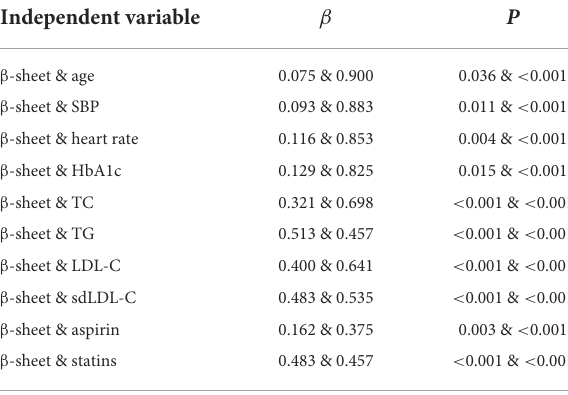
TABLE 2 Summary of multiple linear regression models for β -sheet level and Gensini score